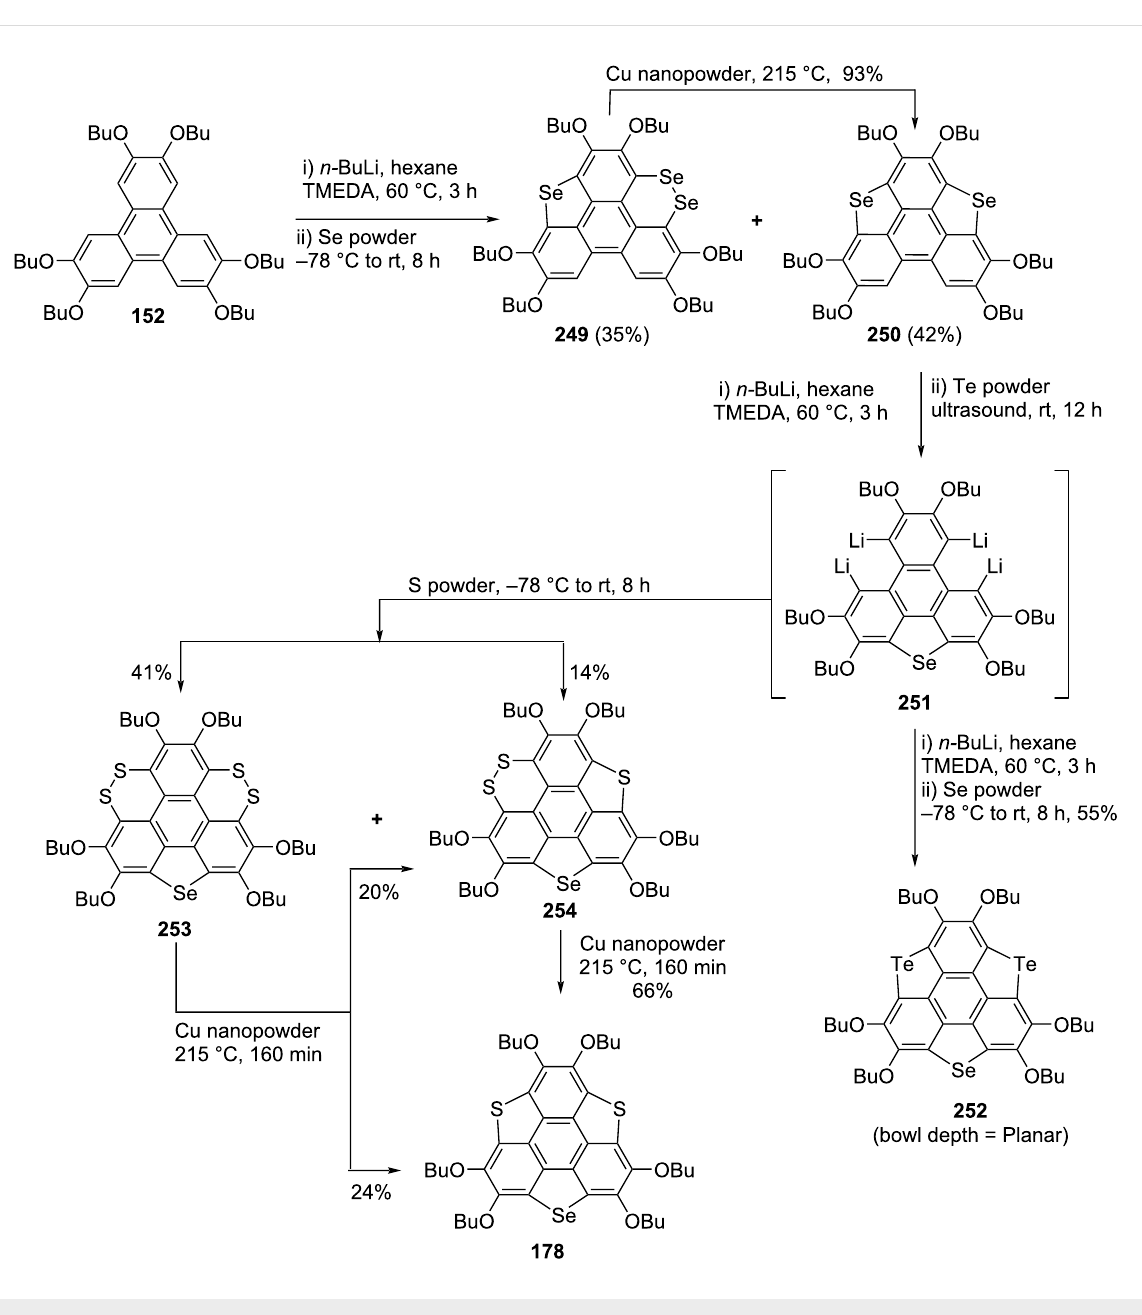
Scheme 60: Design and synthesis of trichalcogenasumanene derivatives 252 and 178